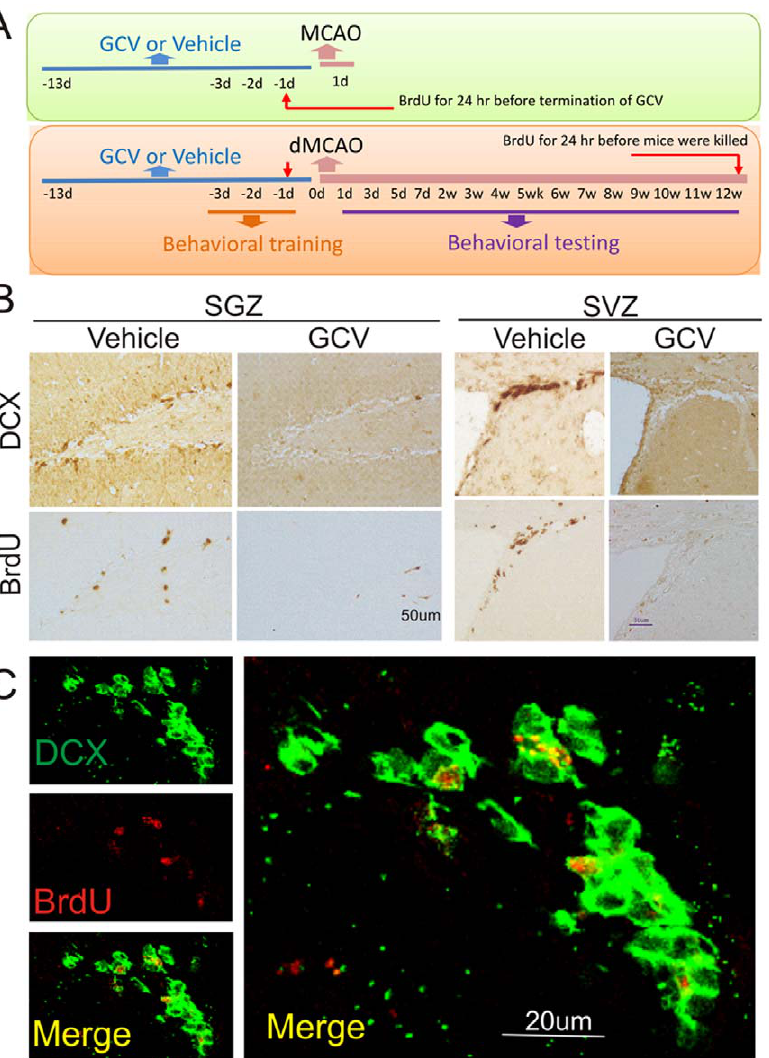
Figure 1. Conditional depletion of DCX- and BrdU-immunopositive cells in SVZ and dentate SGZ of middle-aged DCX-TK ( + ) transgenic mice. ( A ) Middle-aged DCX-TK ( + ) and DCX-TK ( 2 ) mice were treated for 14 days with vehicle or GCV, received behavioral training, and then underwent MCAO or dMACO. Behavioral testing was conducted for 12 weeks after dMCAO, following which some mice were given BrdU on the last day after dMCAO. Mice were then euthanized for measurement of damaged volume and immunocytochemistry. In addition, BrdU was injected at 24 hr prior to termination of GCV administration to test whether neurogenesis was inhibited. ( B ) Representative images of DCX- and BrdU- immunopositive cells in dentate SGZ of middle-aged DCX-TK ( + ) transgenic mice treated with vehicle or GCV (left panel). DCX- and BrdU- immunopositive cells in SVZ of middle-aged DCX-TK ( + ) transgenic mice treated with vehicle or GCV (right panel). ( C ) Representative images of DCX (green)/BrdU-immunopositive cells (red) in SVZ of middle-aged DCX-TK ( + ) transgenic mice treated with vehicle (left pane). High magnification view (right panel) shows that DCX (green) and BrdU (red) were colocalized in single cells.